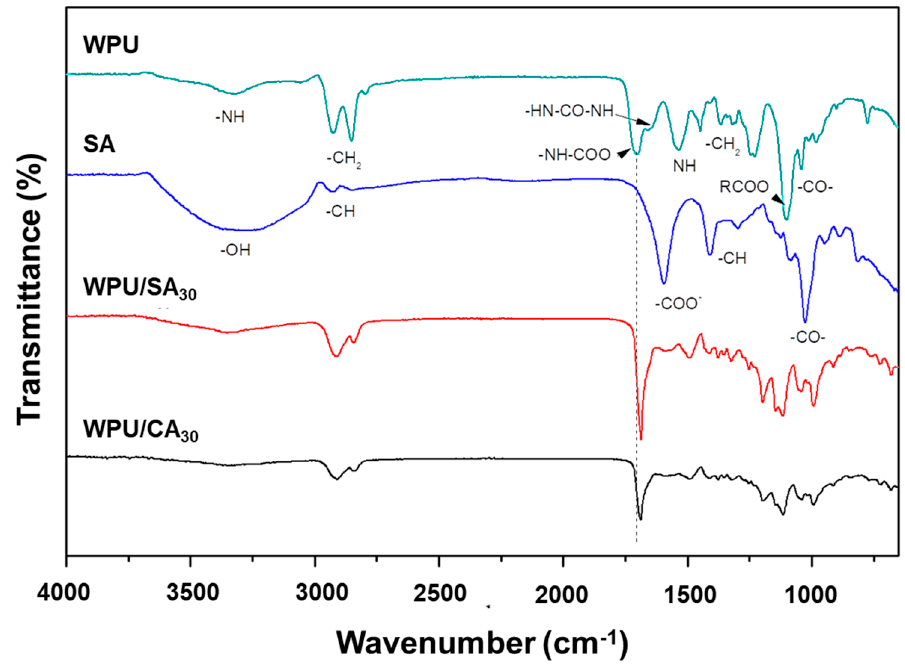
Figure 2. FTIR spectra of the WPU, WPU / sodium alginate (SA), and WPU / calcium chloride (CA) blends.